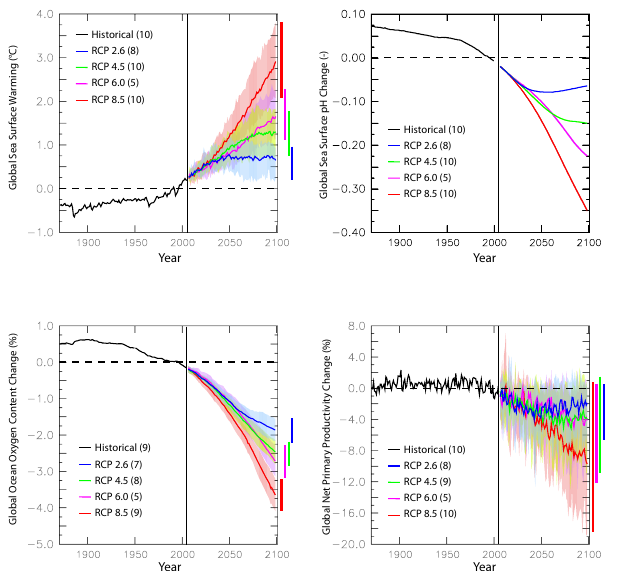
Fig. 4. Individual model time series of global sea surface warming ( ◦ C), surface pH change (pH unit), ocean O 2 content change (%), and global NPP change (%) over 1870–2100 using historical simu- lations as well as all RCP8.5